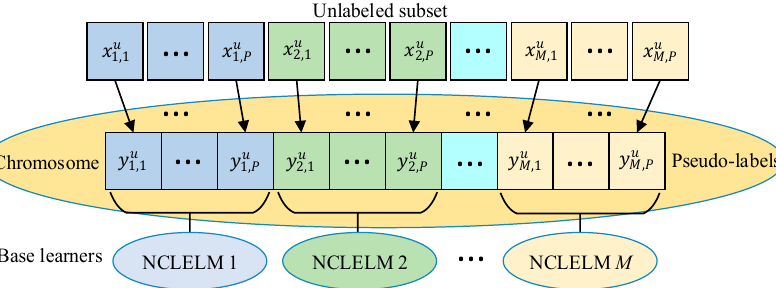
Figure 2. Individual structure for GA-based pseudo-labeling optimization.